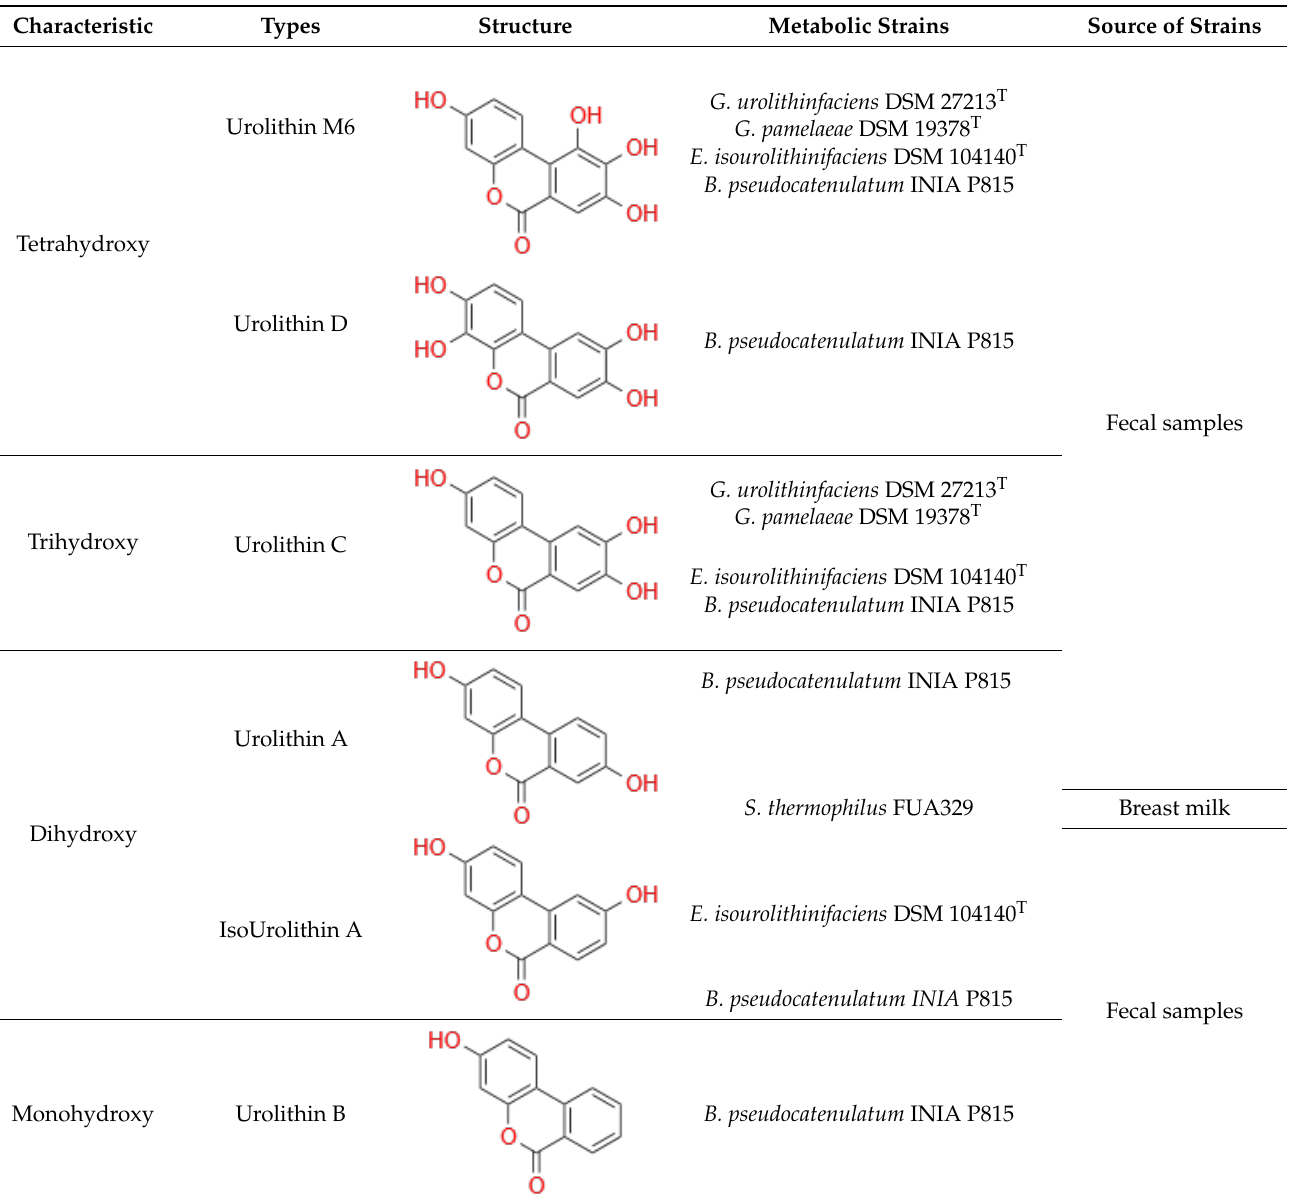
Table 4. Urolithins and urolithins-producing strains [24,27,28,30,58].